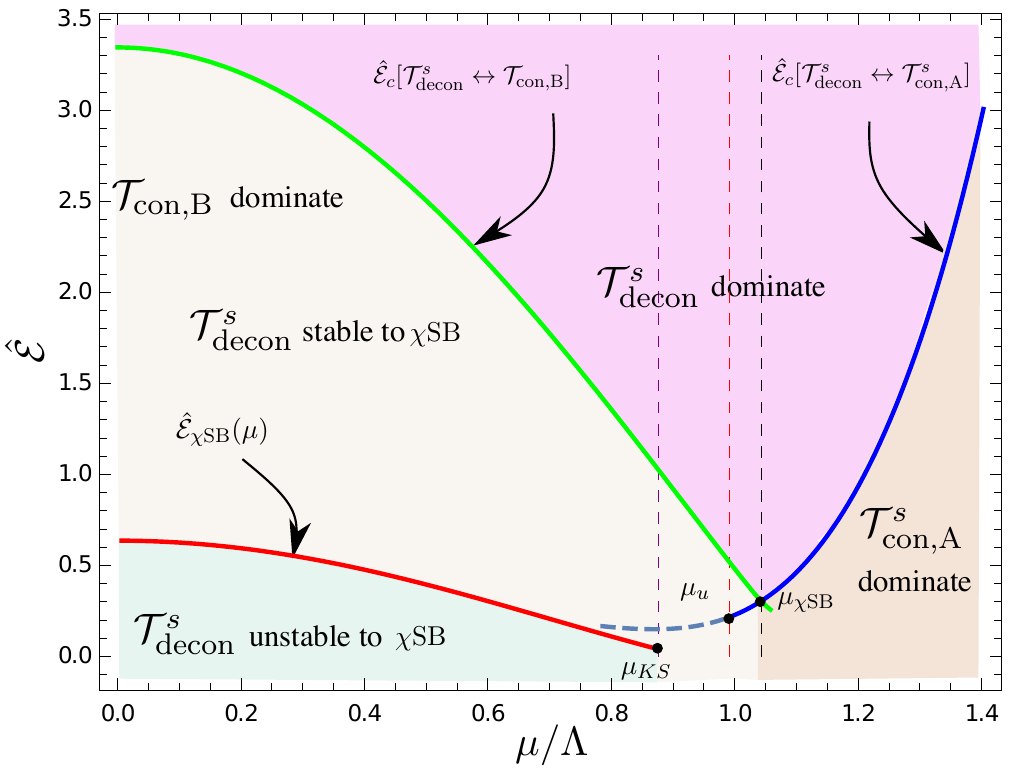
s Figure 25 . Critical energies ˆ of states (Klebanov-Tseytlin black holes) for different con- decon E c T finement/deconfinement phase transitions. The deconfined states are preferred above green and blue curves. The Klebanov-Tseytlin black holes become unstable to χ SB fluctuations below the red curve ˆ ( µ ). The Klebanov-Strassler black holes exist only for ˆ E χ SB µ < µ KS